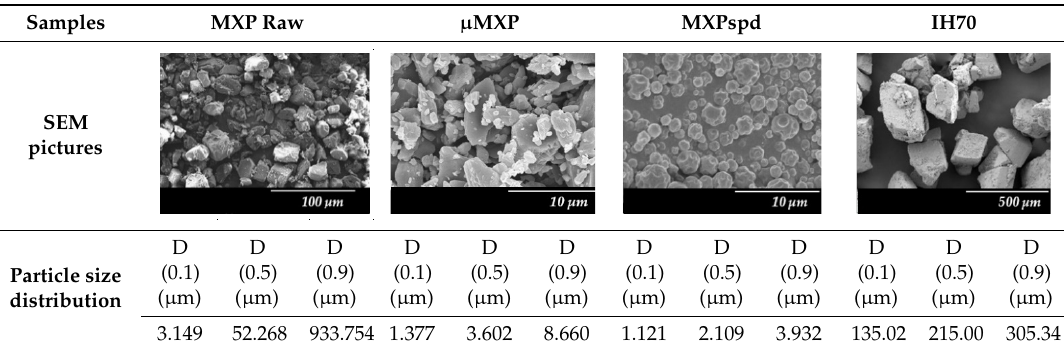
Figure 3. SEM recordings and schematic pictures of the carrier-based samples: ( a ) µMXP + IH70, ( b ) µMXP + IH70_MgSt, ( c ) MXPspd + IH70, and ( d ) MXPspd + IH70_MgSt.